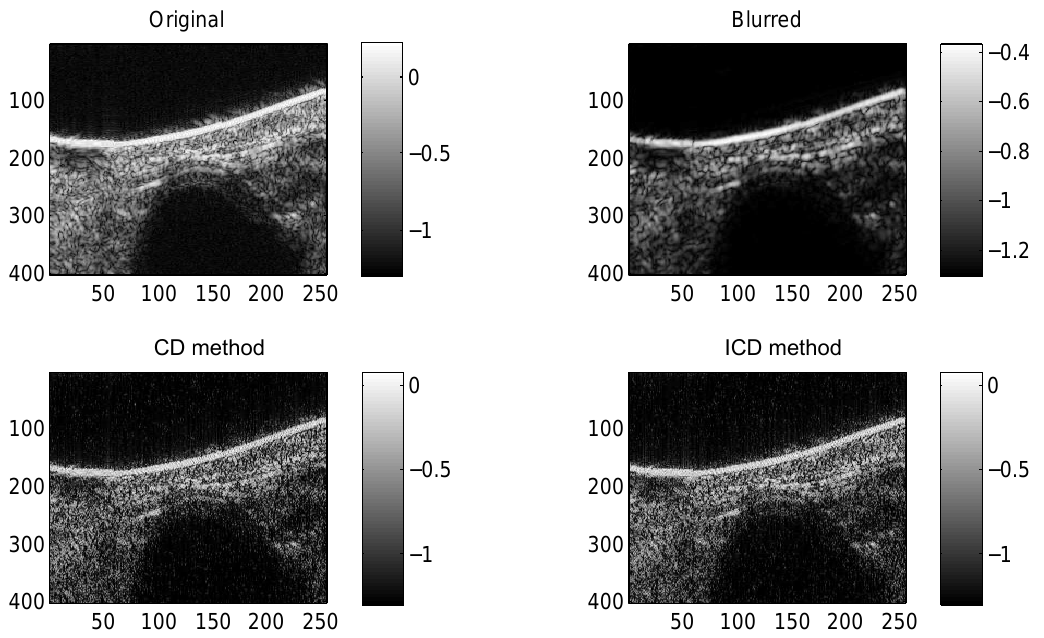
Figure 3. Results on Mouse bladder with CS ratio = 0.4.